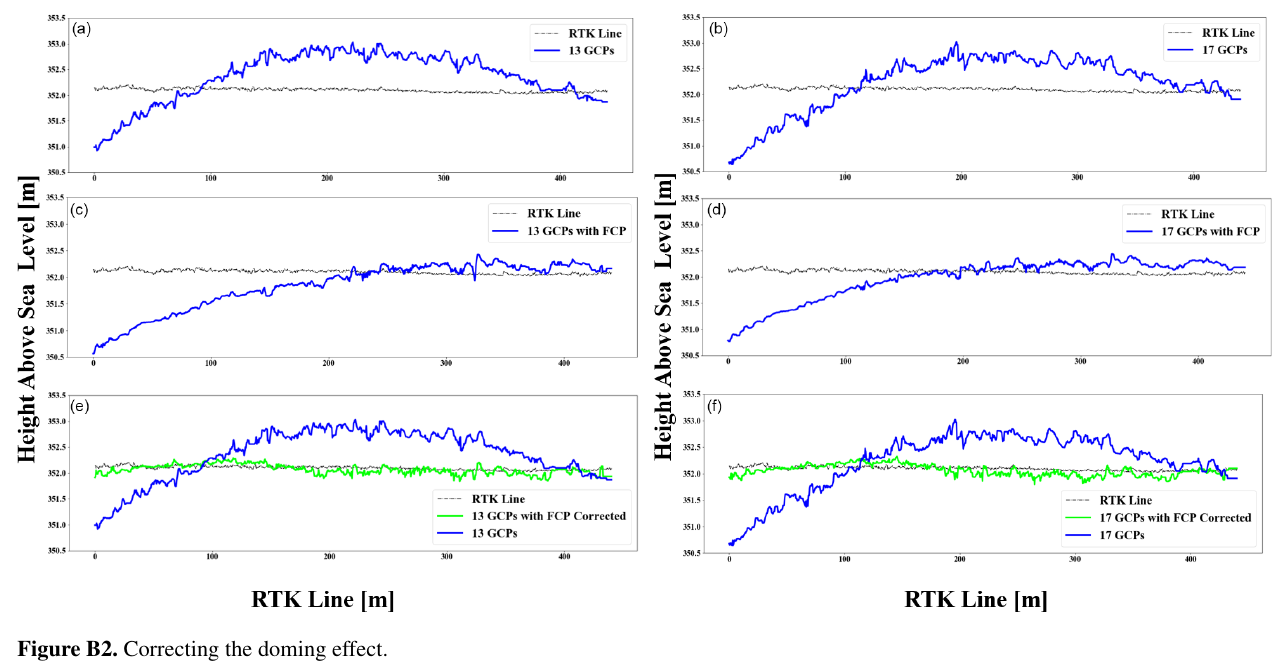
Figure B2. Correcting the doming effect.